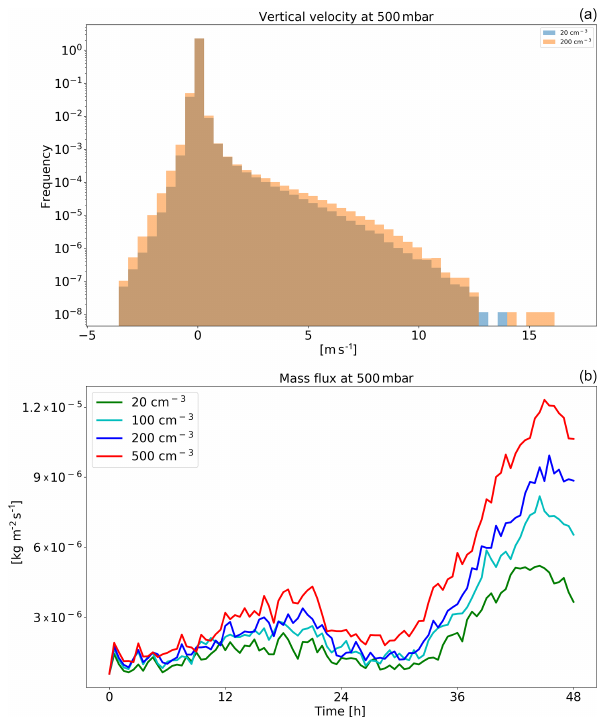
Figure 11. Histograms of ICON-simulated vertical velocity at the level of 500mbar for clean (CDNC = 20cm − 3 ) and polluted (CDNC = 200cm − 3 ) simulations (a) , and the time evolution of the net upwards water (liquid and ice) mass flux (b) for the differ- ent CDNC simulations for the shallow-cloud-dominated case (10– 12 August 2016). The 500mbar level is chosen, as it represents the transition between the warm part to the cold part of the clouds. In the histogram only two simulations are presented for